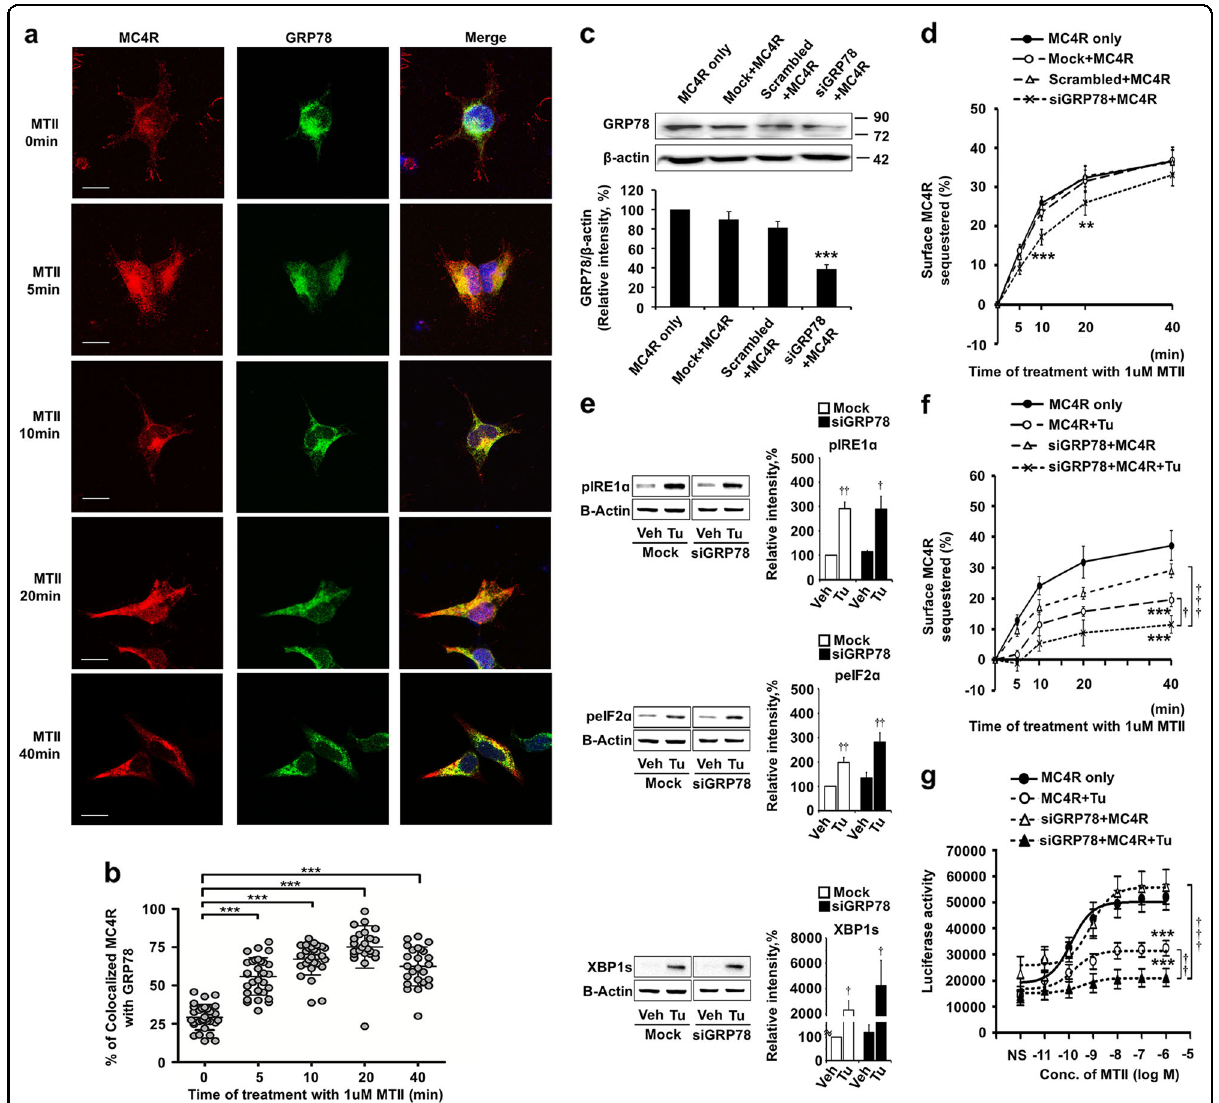
Fig. 2 Cellular colocalization of MC4R and GRP78, and GRP78 downregulation of MC4R traf fi cking and intracellular signaling. The intracellular localization of MC4R and GRP78 was analyzed in the absence and presence of the MC4R agonist MTII in HEK 293T cells overexpressing 3xFlag-MC4R and GRP78-Myc plasmids. To observe the effect of GRP78 knockdown, HEK 293T cells were sequentially transfected with siRNA against GRP78 (siGRP78) and the 3xFlag-MC4R plasmid. siGRP78 and 3xFlag-MC4R-expressing HEK 293T cells were treated with 2.5 µg/ml tunicamycin (Tu) to induce ER stress. Surface receptors were measured by ELISA, and intracellular signaling was analyzed by a CRE-mediated luciferase assay. a Time course of MTII treatment of HEK 293T cells expressing 3xFlag-MC4R (labeled with Alexa Fluor 568, red) and GRP78-Myc (labeled with Alexa Fluor 488, green) proteins. After treatment with 1 µM MTII, cells were fi xed at 5, 10, 20, and 40 min and immunostained (Scale bar, 20 µm). b Quanti fi cation of colocalized MC4R with GRP78. Student ’ s t test for b : 0 min, n = 31; 5 min, n = 30; 10 min, n = 28; 20 min, n = 24; 40 min, n = 25; *** P < 0.0001 versus 0 min control. c Downregulation of GRP78 in siGRP78-transfected cells compared to that in control-transfected cells. Control plasmids included a mock (empty vector lacking a siRNA sequence) and a scramble (vector containing an siRNA sequence that was designed not to degrade any speci fi c cellular message). d The percentage of sequestered MC4R, shown as a ratio of the total number of receptors to internalized receptors, after GRP78 knockdown. e Expression of ER stress marker proteins after ER stress induction: phosphorylated inositol-requiring enzyme 1 α (pIRE1 α ), phosphorylated eukaryotic initiation factor 2 α (peIF2 α ), and spliced X-box-binding protein 1 (XBP1s). After treatment with 2.5 µg/ml tunicamycin for 3 h in cells transfected with control mock vector or with siGRP78, cell lysates were analyzed for levels of pIRE1 α , peIF2 α , XBP1s, and β -actin (as a control for normalization) by western blotting. f The ratio of the total receptors to internalized receptors under GRP78 knockdown and ER stress to illustrate the percentage of sequestered MC4Rs. g Relative cAMP-mediated transcriptional activity stimulated with various concentrations of MTII during GRP78 knockdown and ER stress. The results are shown as the mean ± SEM of at least three independent experiments performed in triplicate. One-way ANOVA, Bonferroni post hoc tests for c ; two-way ANOVA, Bonferroni post hoc tests for d , f , and g : * P , † P < 0.05, ** P , †† P < 0.001, and *** P , ††† P < 0.001; *, P , versus MC4R only or si-mock; † , P , versus siGRP78 + MC4R + Tu or vehicle; One-tailed Student ’ s t test for e : † P < 0.05, †† P < 0.001, and *** P < 0.001; *, P , versus si-mock; † , P , versus vehicle. The data are presented as the mean ±